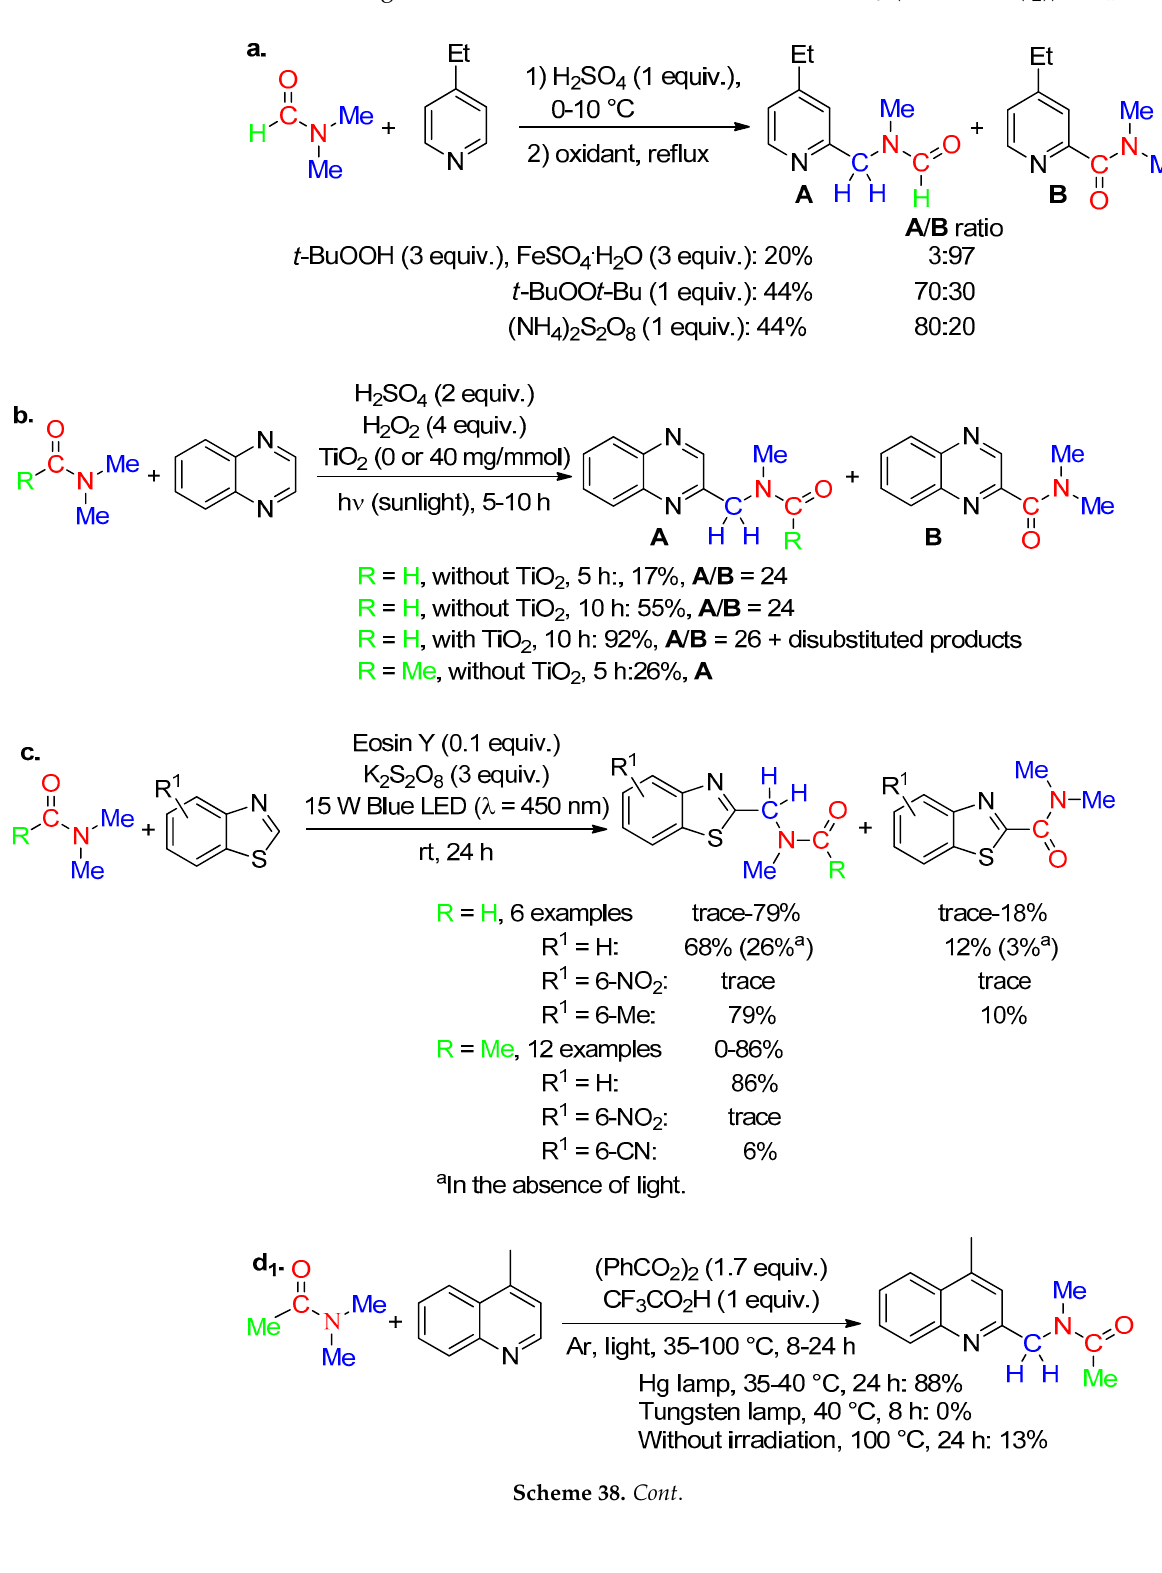
the process [125]. Under Cu 2 O catalysis, oxidation of styrene with Na 2 S 2 O 8 in DMF pro- vided a 3:1 mixture of N -cinnamyl- N -methylformamide and N , N -dimethylcinnamamide (Scheme 38h) [126]. The Ni(cod) 2 / t -BuOOH association in DMAc mediated the selective carbamoylation of α , α -diaryl allylic alcohols while amidation was a competitive path- way in DMF (Scheme 38(i 1 )) [127]. Both pathways involve a radical 1,2-aryl migration succeeding to the reaction of the substrate with either I 9 (Scheme 38(i 2 )) or I 4 .